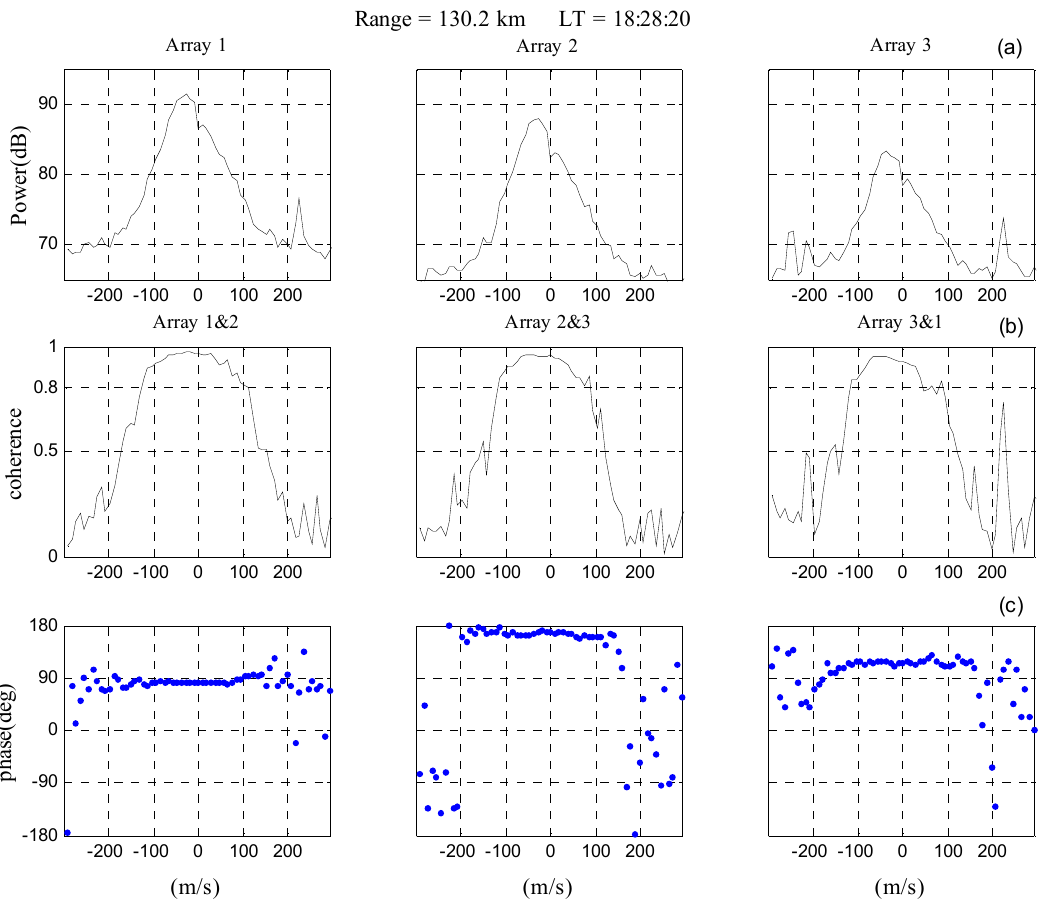
Fig. 2. ( a ) A sample power spectrum of backscatter signals from E s irregularities received by three antenna arrays observed on 3 July 2000. ( b ) Coherence and ( c ) Phase obtained through cross-spectral analysis for array pairs of 1–2, 2–3, and 3–1 are shown from the left panel to the right panel,